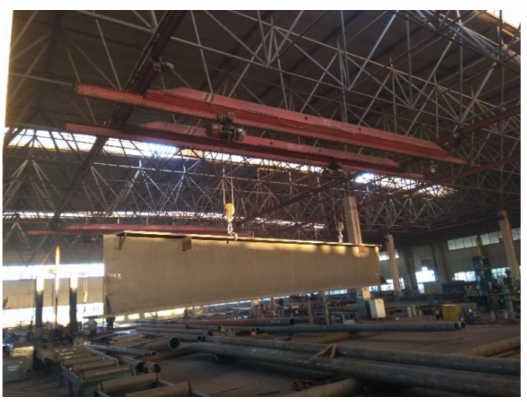
Figure 1. The applications of grid structures with suspended